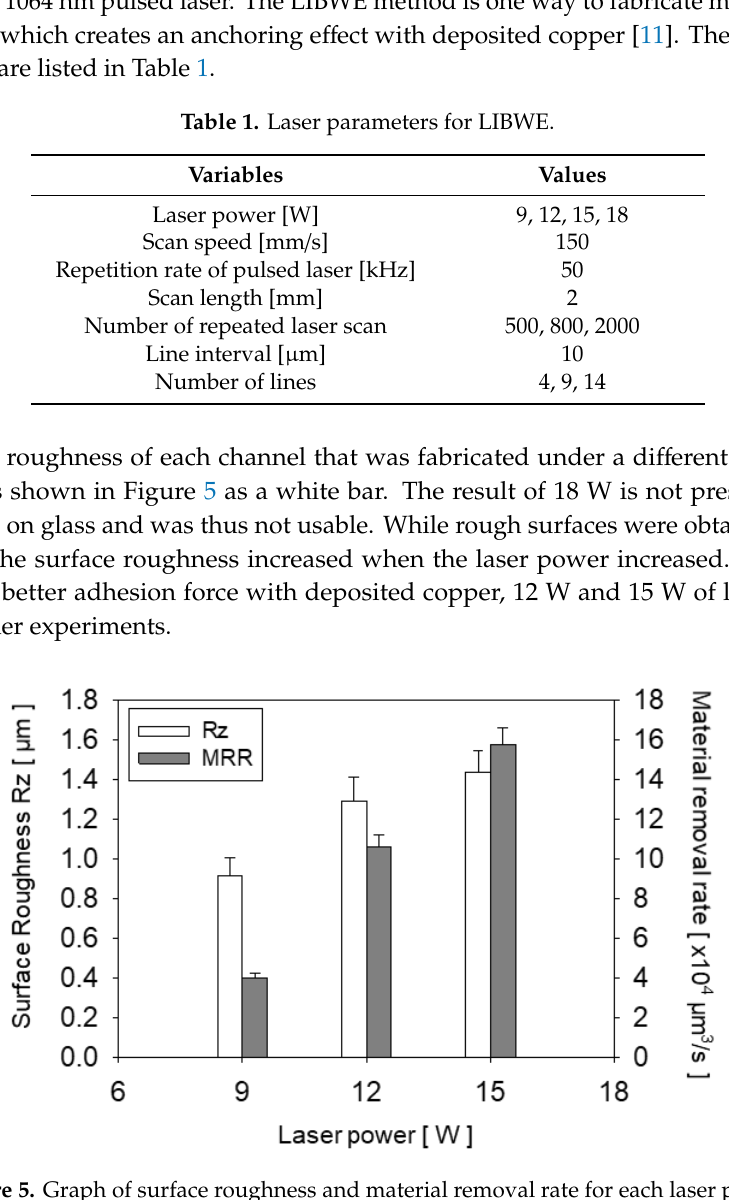
Figure 5. Graph of surface roughness and material removal rate for each laser power.